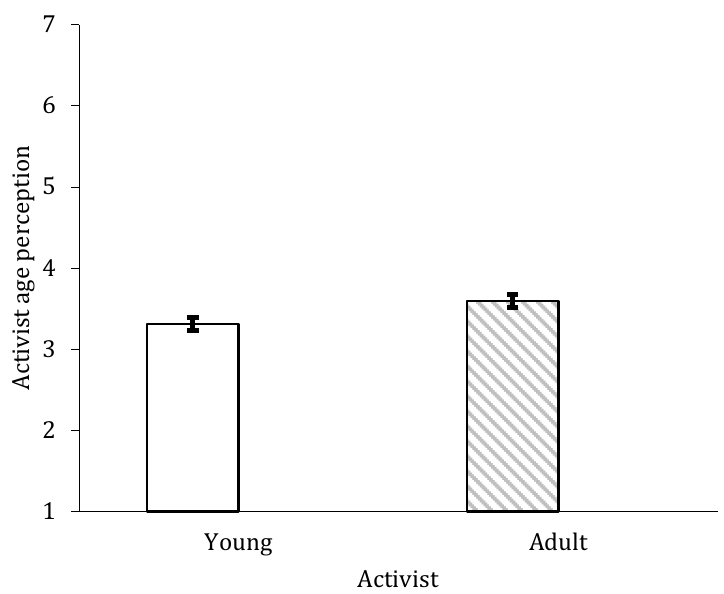
Figure 7. Means and standard errors regarding the perceived activists age by experimental conditions.